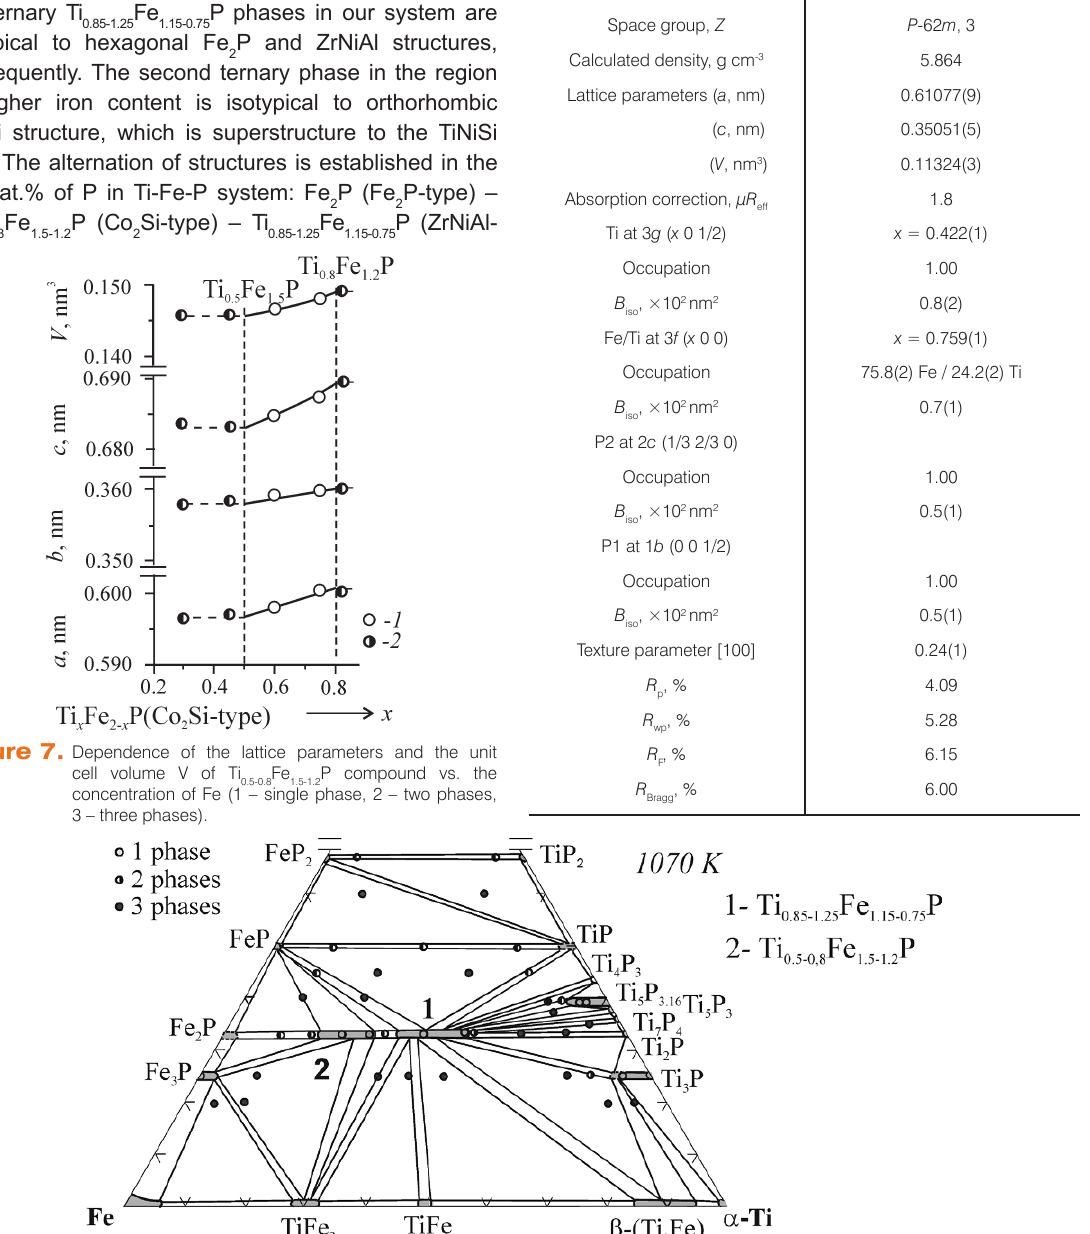
Figure 8. Chemical and phase composition of samples and isothermal section of the Ti-Fe-P system at T = 1070 К